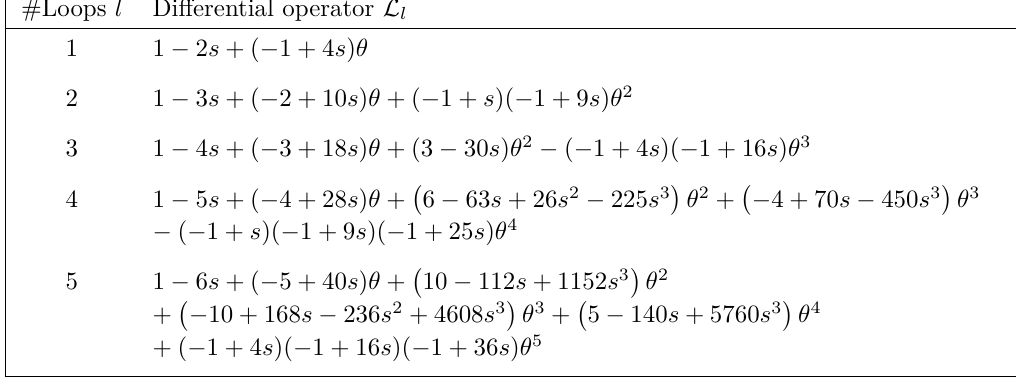
Table 1 . Homogeneous differential operators for maximal cut